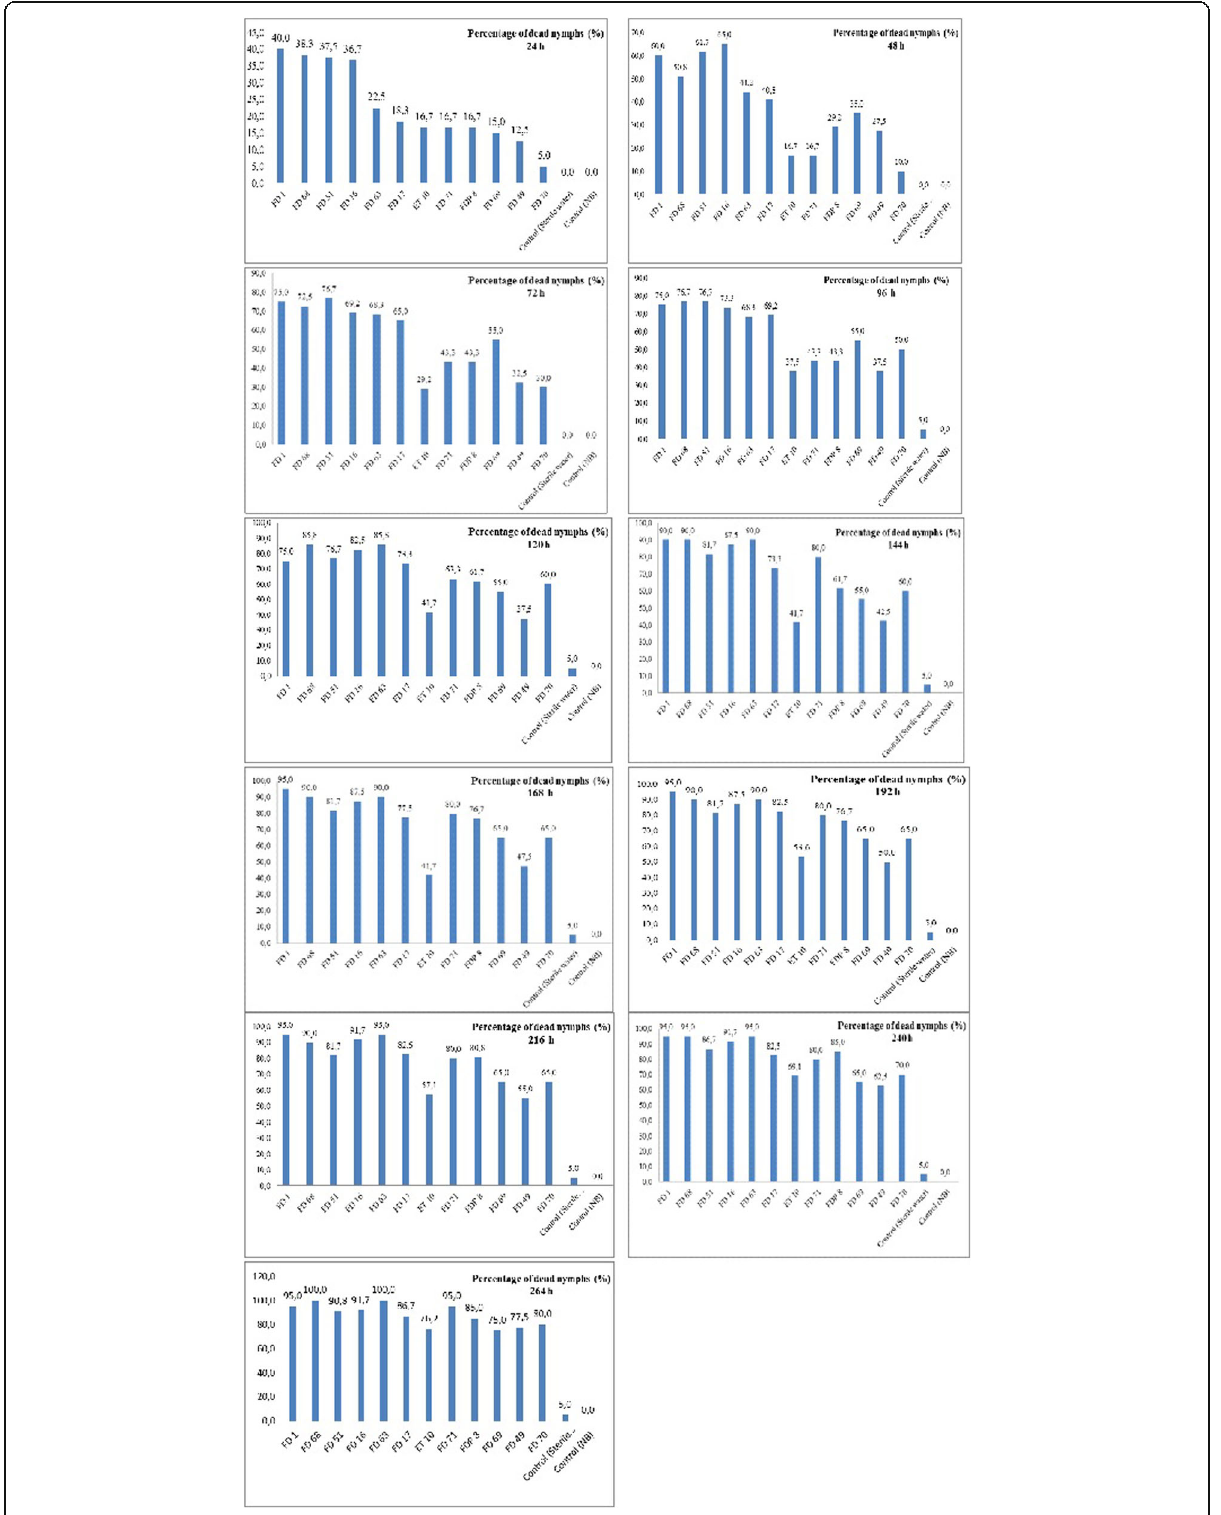
Fig. 1 Percentages of mortality of Halyomorpha halys nymphs in response to some entomopathogenic bacterial strains and fungal isolates by